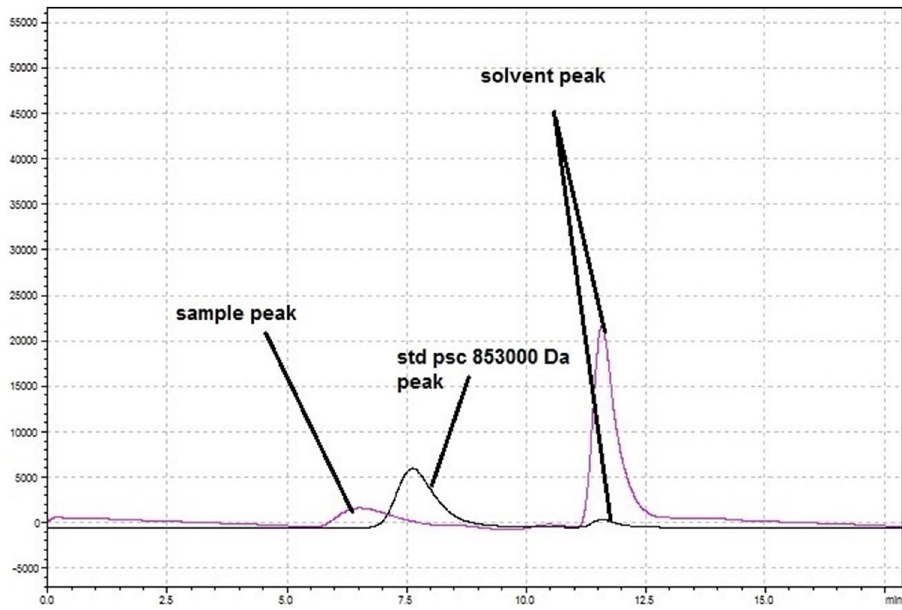
Figure 3. GPC analysis of the HA extracted from the transgenic hairy roots. The first pink peak showed HMW-HA > 853,000